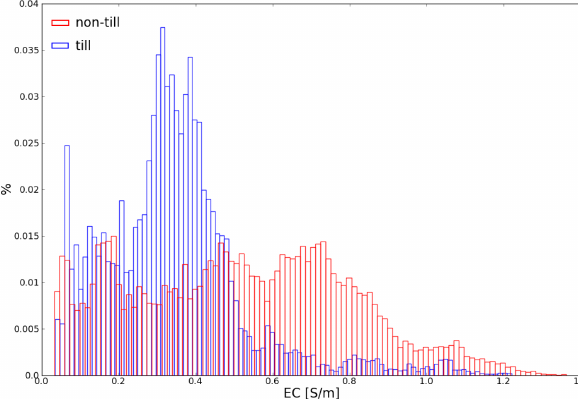
Fig. 4. Distribution of EC for intervals with and without glacial